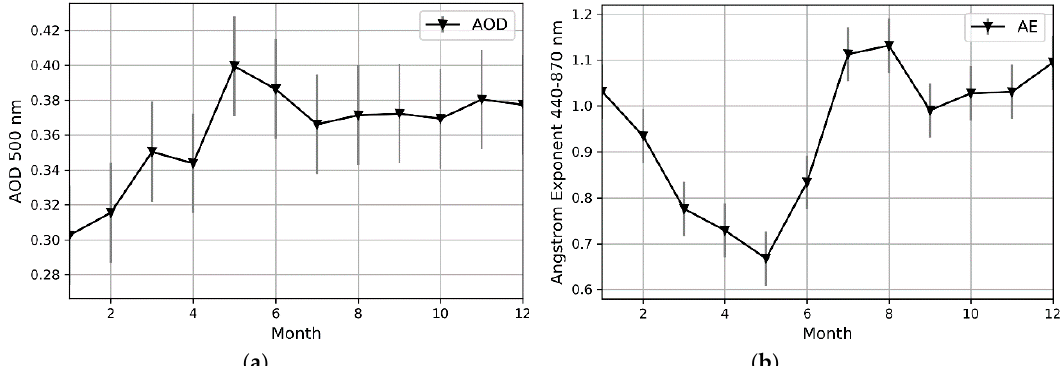
Figure 9. Time series of AERONET AOD for the period 2012–2018 from Cairo EMA-2 station, ( a ) AOD at 500 nm, ( b ) Ångström exponent (AE) 440–870 nm.